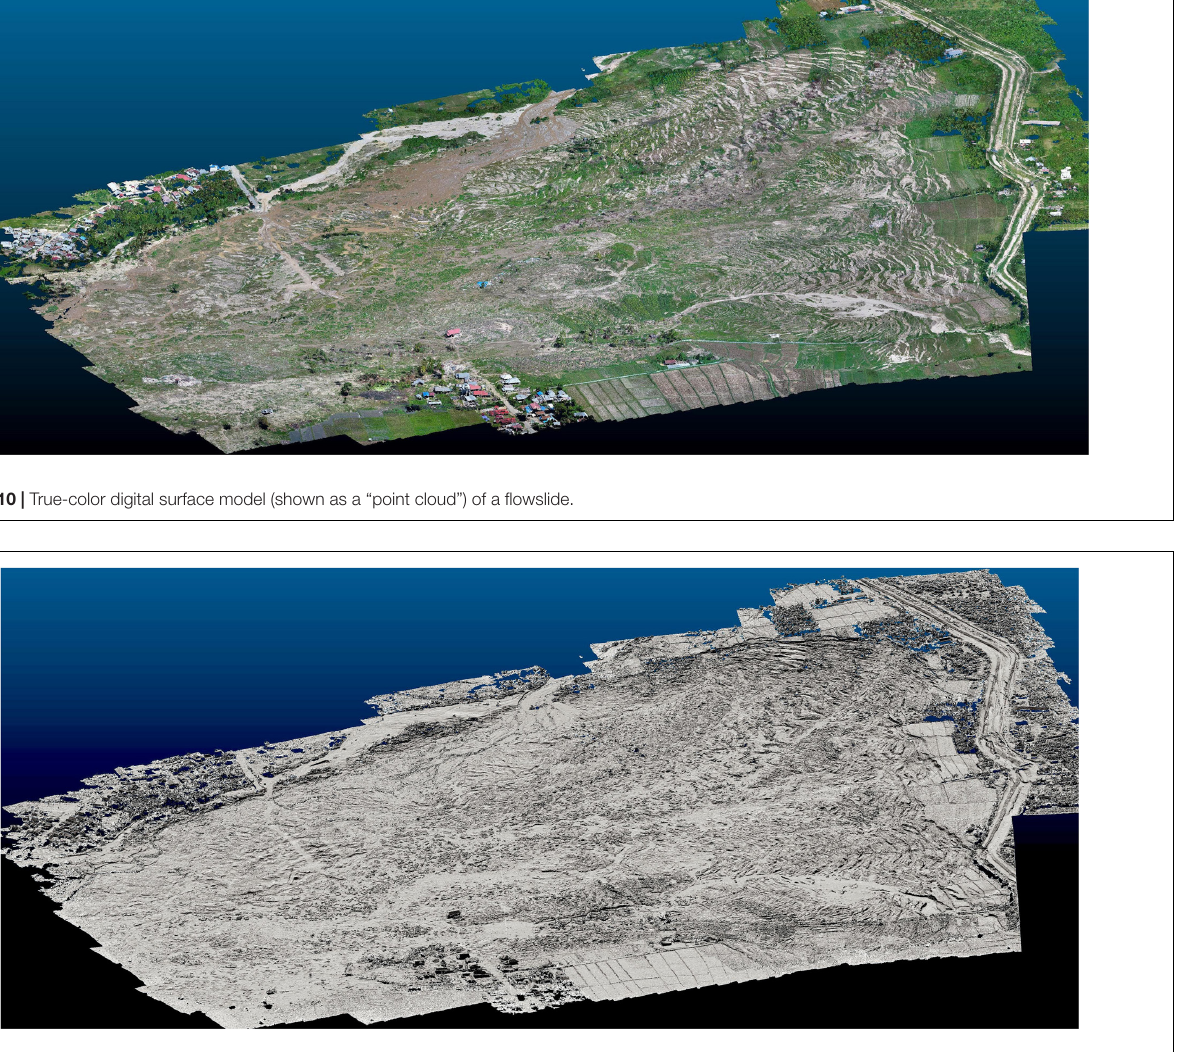
FIGURE 11 | Shaded relief digital surface model of a flowslide. North is toward the top. Simulated sunlight shines southward at 45 ◦ to the